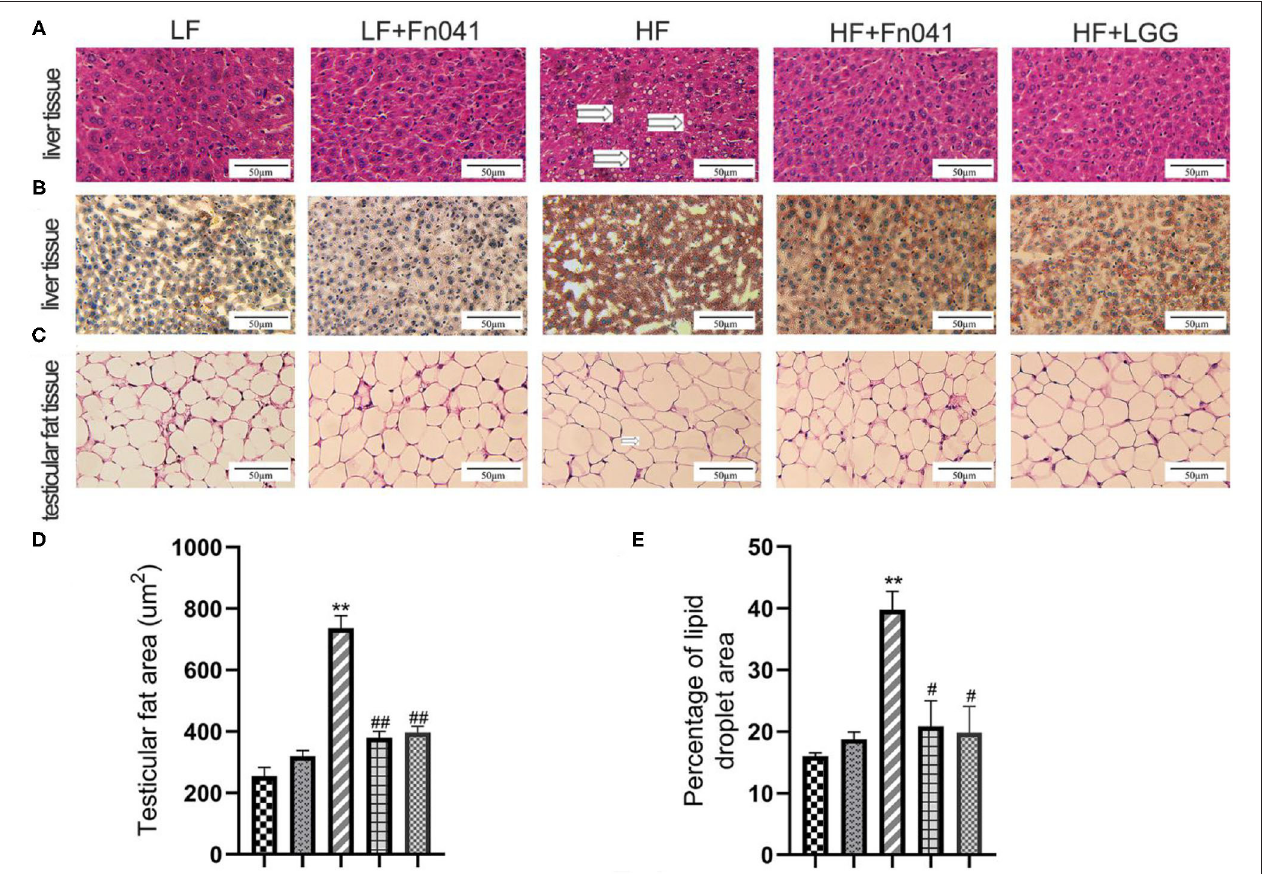
FIGURE 2 | Effect of Lactobacillus reuteri Fn041 on the morphology of the liver and testicular fat. (A) H&E staining of the liver; (B) Oil Red O staining of the liver; (C) H&E staining of the testicular fat; (D) Adipocyte size ( n = 5/group); (E) Percentage of lipid droplet area ( n = 5/group). ** p < 0.01 as compared with the LF group; # p < 0.05, ## p < 0.01 as compared with the HF group. LF, low-fat diet group; LF + Fn041, low-fat diet group treated with L. reuteri Fn041; HF, high-fat diet group; HF + Fn041, high-fat diet group treated with L. reuteri Fn041; HF + LGG, high-fat diet group treated with Lactobacillus rhamnosus